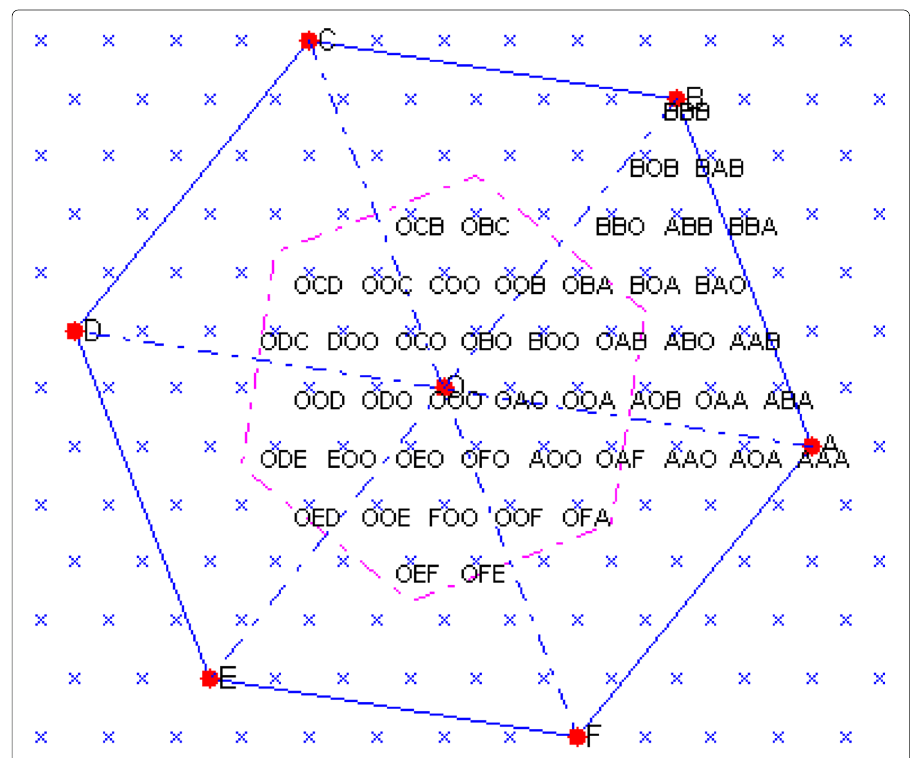
Fig. 1 Index assignment based on A 2 lattice with N = 31. Lattice points λ , sublattice points λ (cid:2) are marked by × and • , respectively multiresolution representation and subband decomposition for images and capture fea- ture information in horizontal, vertical, and diagonal directions [52]. DWT is considered for image coding in this paper. After applying a DWT to the input image, an input vector x is constructed in a subband. It is then quantized to a (fine) lattice point λ( x ) , which is ( x ) , λ (cid:2) ( x ) , and λ (cid:2) ( x ) to be transmitted in separate mapped to three sublattice points λ (cid:2) 1 2 3 channels after performing arithmetic coding.